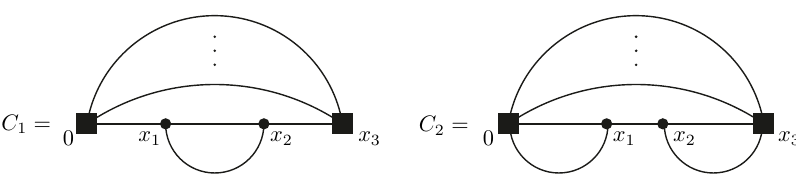
ρ n ( x 3 ) ρ n (0) at order 1 /N . The h i